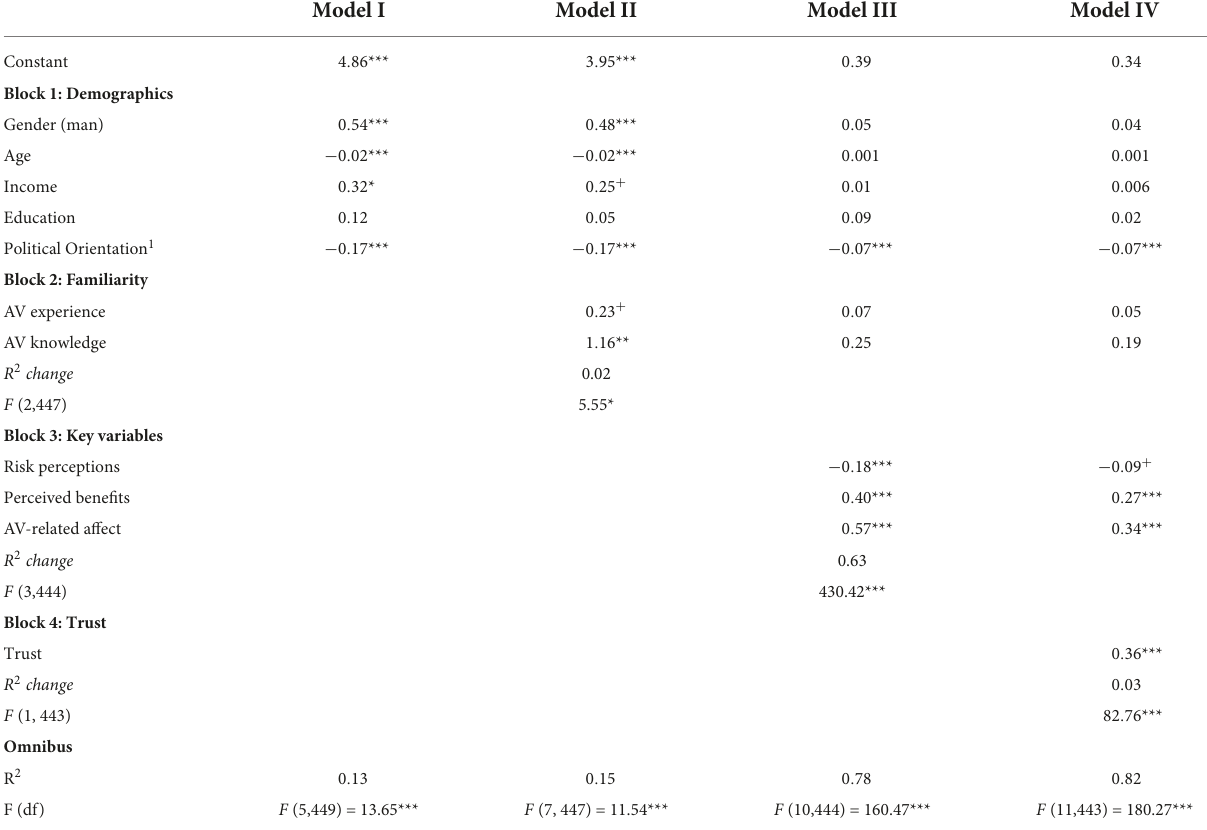
TABLE 1 Study 1 hierarchical regression models predicting autonomous vehicle (AV) policy support ( N =